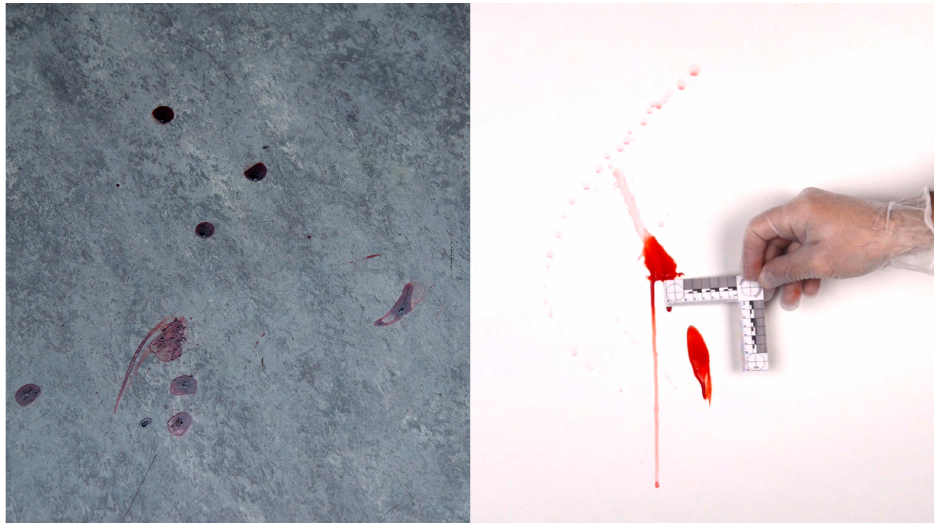
Figure 1. ( Left ) Blood stains on a floor, photographed without a size reference, making its dimensions impossible to judge. ( Right ) Blood stain on a white wall, with a physical size reference held close to it by an assistant, which introduces a risk of touching and altering or transferring the trace material.